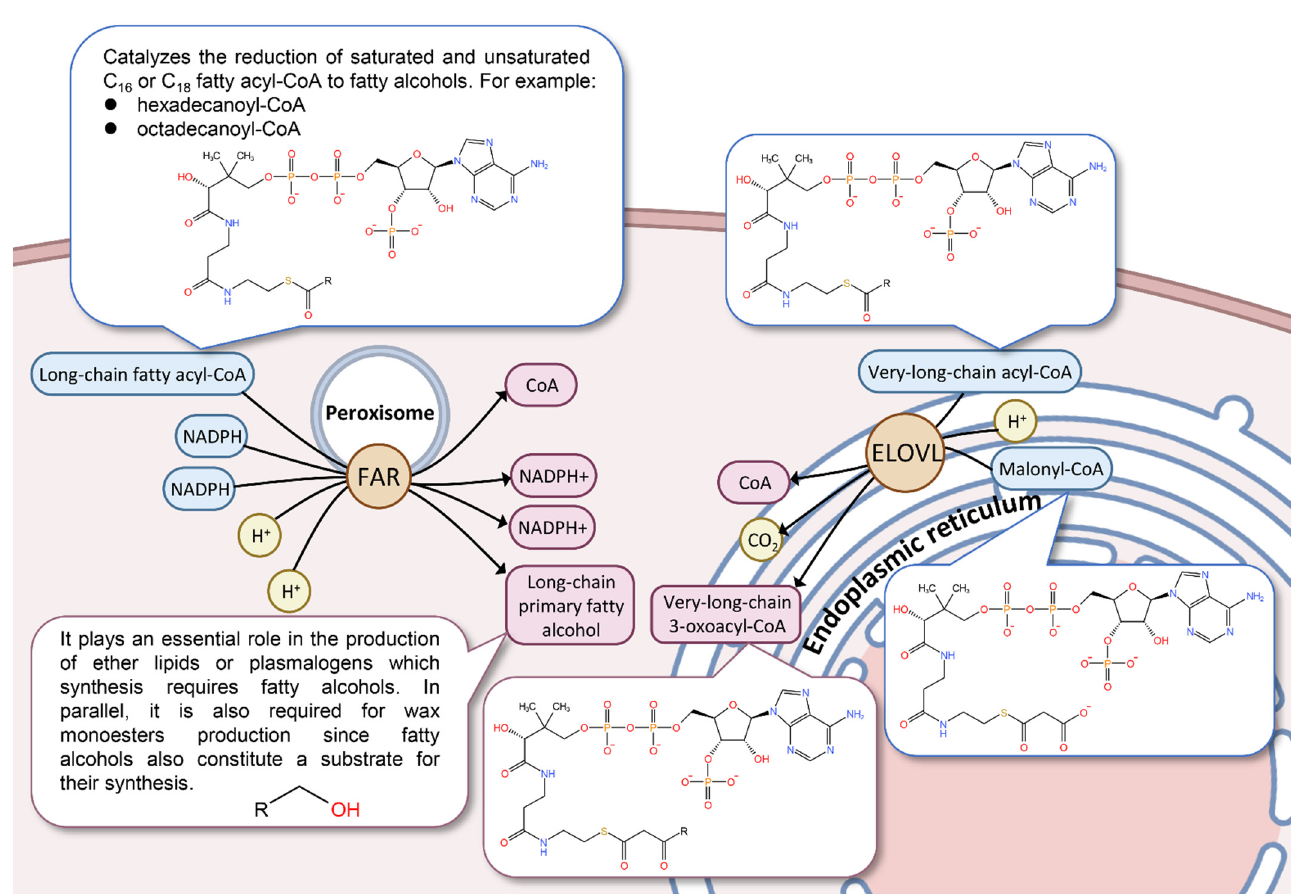
Figure 5. Schematic diagram of intracellular long-chain primary fatty alcohol and very-long-chain 3-oxoacyl-CoA synthesis pathway. This schematic diagram is based on the functional and subcellular location introduction of elongation of ELOVL (UniprotID: Q1HRV8) and FAR (UniprotID: Q7ZXF5) in the Uniprot database. The text, chemical structure, and abbreviation in the figure are all from the Uniprot database. Both the peroxisome and the endoplasmic reticulum are schematic, and their size and scale are not drawn according to the actual size and scale of the